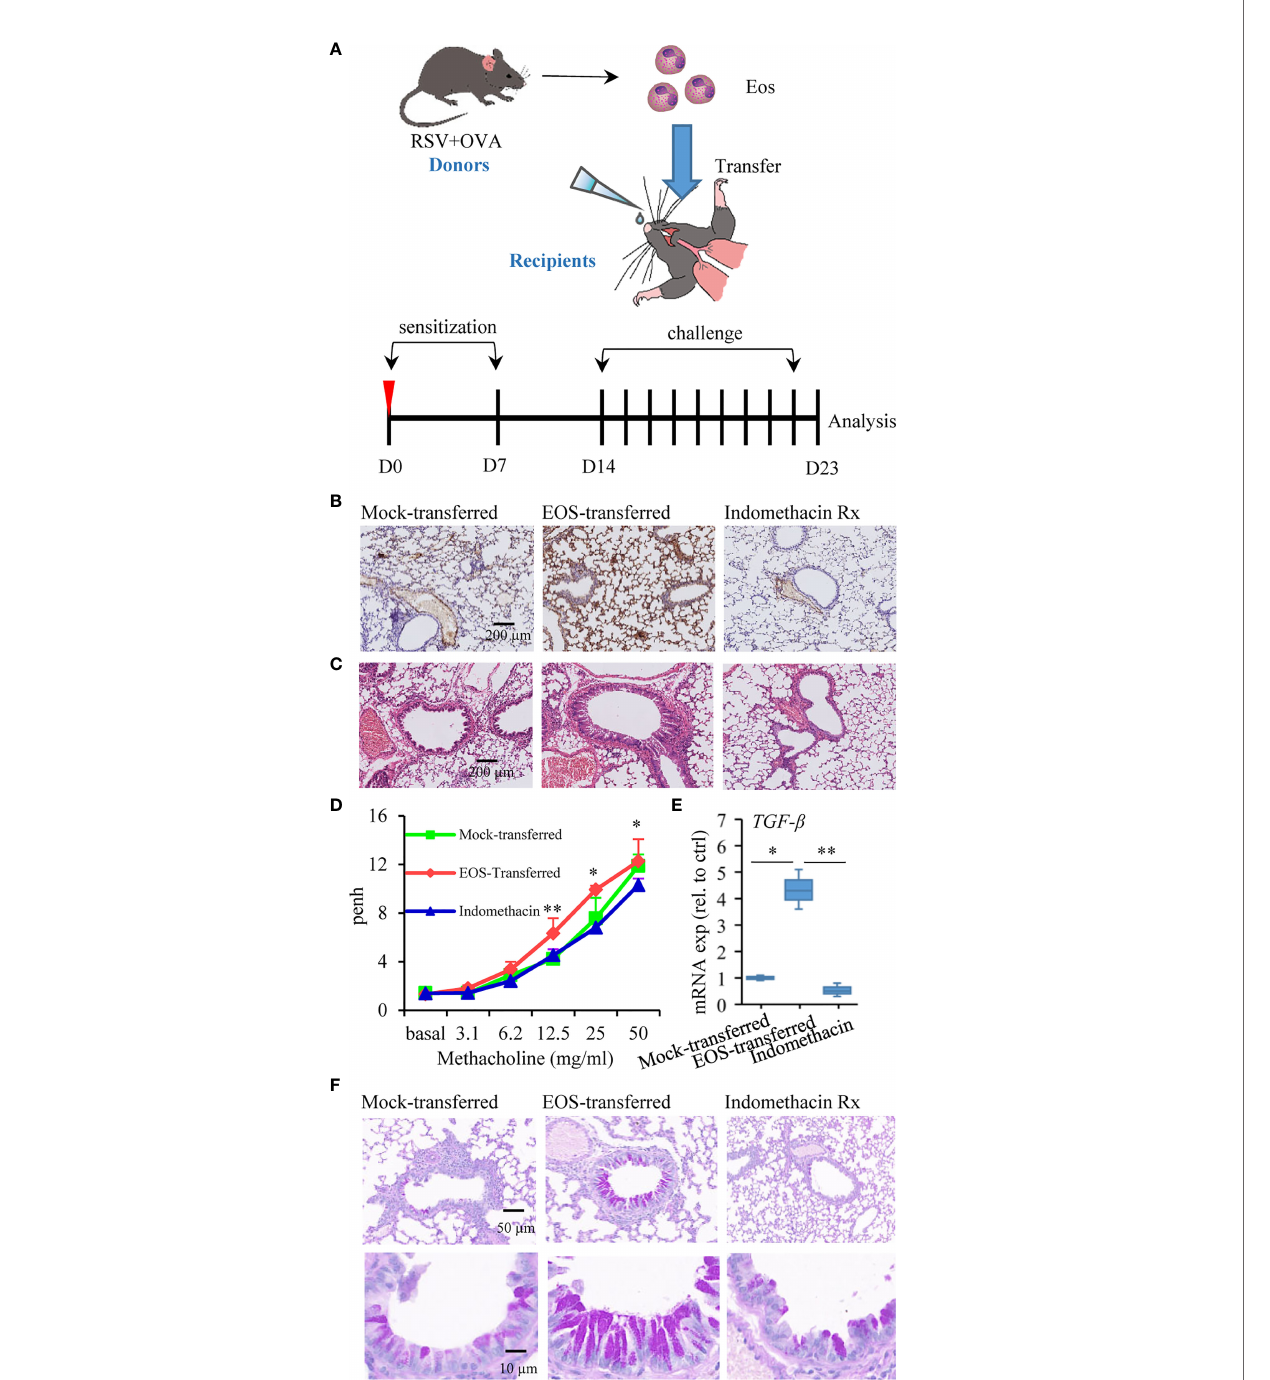
FIGURE 4 | Adoptive transfer of asthmatic eosinophils results in increased susceptibility to allergen stimulation. (A) Schematic timeline of the experimental model of asthma mice after being transferred, in which mice were treated by OVA sensitization and challenge. (B) MBP protein immunohistochemistry staining was used to detect the presence of eosinophils in lung tissue sections of mock-transferred, EOS-transferred, and indomethacin-treated mice. The scale bar is 200 m m. (C) Images show representative H&E-stained sections from each group. The scale bar is 200 m m. (D) AHR of mice is measured by monitoring Penh in response to gradient concentration (0, 3.1, 6.2, 12.5, 25, and 50 mg/ml) of inhaled MCh. The three sets of asterisks from left to right are EOS-transferred vs. mock-transferred, EOS-transferred vs. mock- transferred, indomethacin vs. EOS-transferred. (E) TGF- b expression in the lung tissues measured by RT-qPCR ( n = 3). (F) PAS staining was performed to monitor mucus production in bronchial goblet cells (bright purple staining). The scale bar is 50 m m (the upper picture) and 10 m m (the lower picture). * p < 0.05, and ** p <